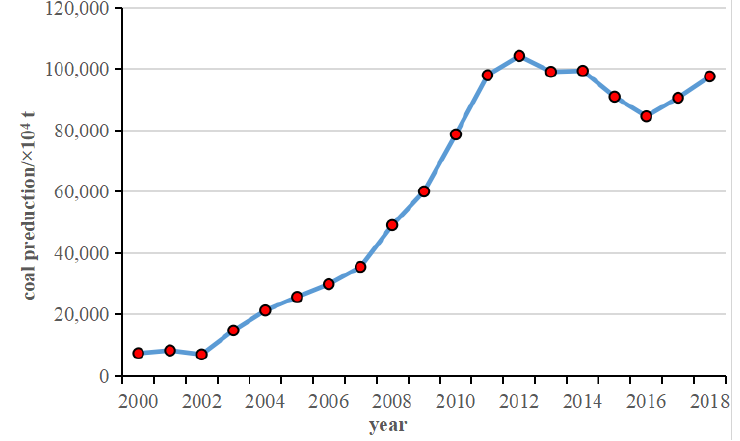
Figure 8. Changes in the amount of coal mining in Inner Mongolia.